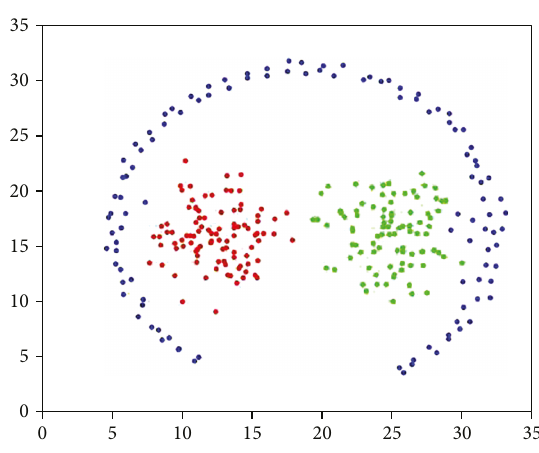
Figure 13: The distribution of